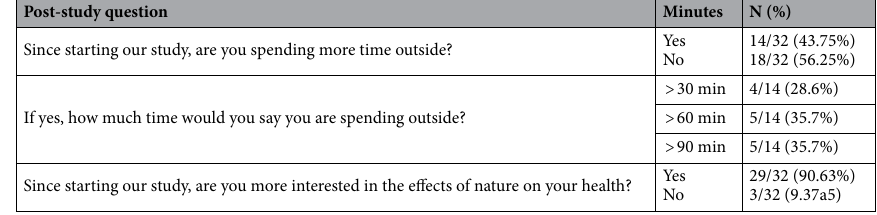
Table 4. Post-study questionnaire.